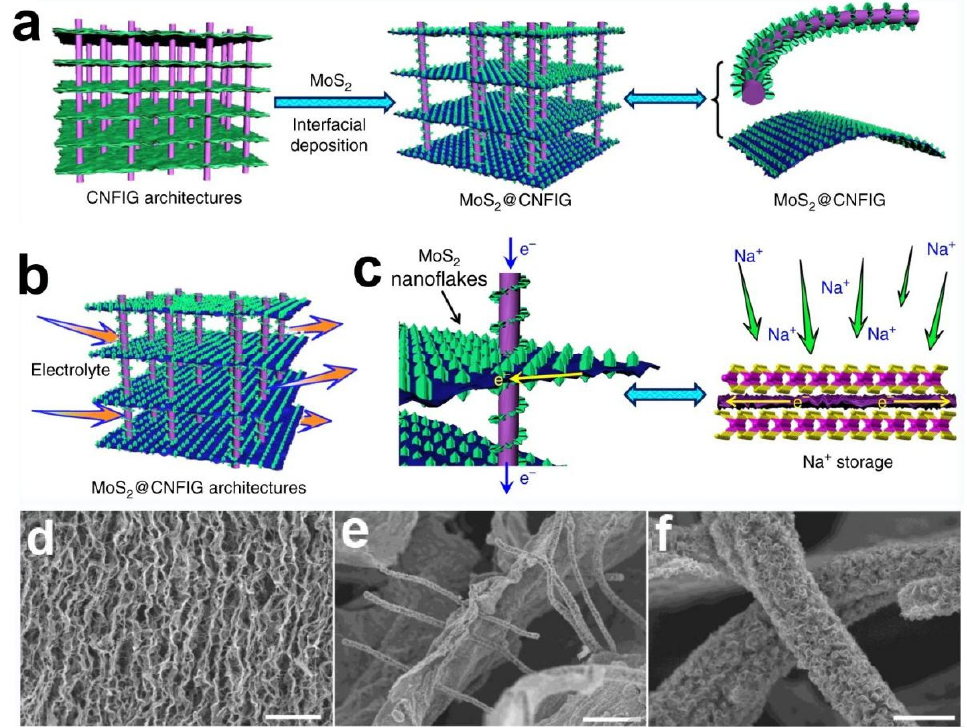
Figure 20. Schematic illustration of ( a ) homogeneous deposition of MoS 2 nanoflakes on layered CNFIG matrix, ( b ) The mechanism of porous morphology of MoS 2 @CNFIG nanocomposite accelerates the penetration of electrolyte and ( c ) the mechanism of electrically conductive MoS 2 @CNFIG facilitates the quick sodiation/desodiation ability and rapid transfer of sodium ions; SEM images of the MoS 2 @CNFIG nanocomposite: ( d ) overall structure with a scale bar of 50 μ m and ( e ) cross section with scale bars of 5 μ m; ( f ) MoS 2 layers uniformly deposition on the graphene layer and CNF bridges with a scale bar of 2 μ m. Reproduced with permission [118]. Copyright 2019, Springer Nature.